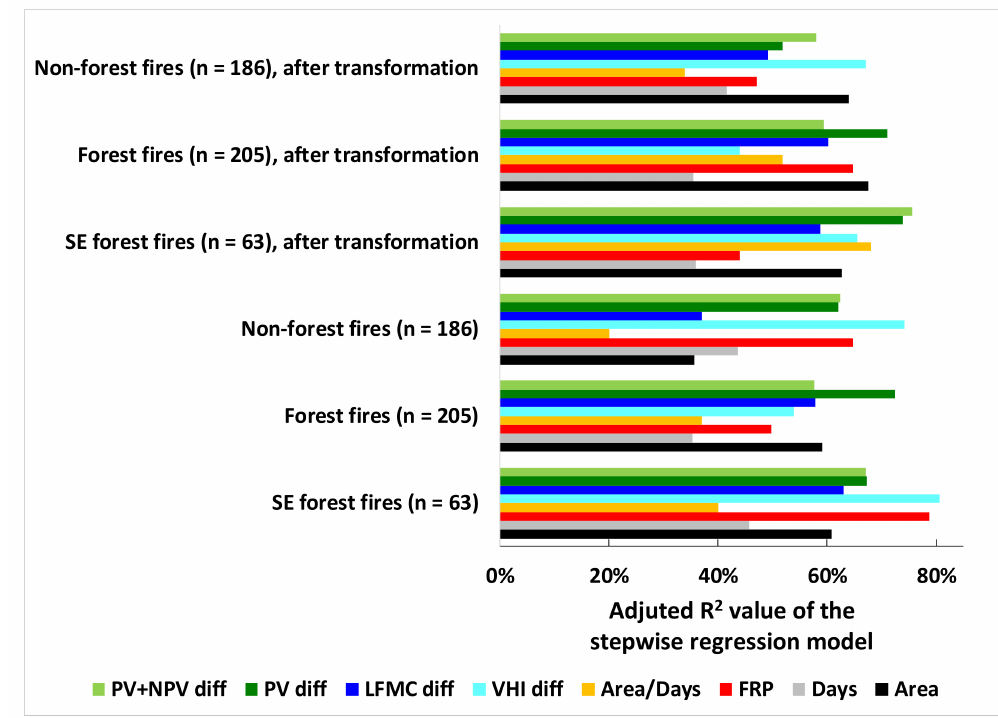
Figure 12. Adjusted R 2 values of the stepwise regression models for the Black Summer fires. Models were run for all response variables, the non-forest fires ( n = 186), the forest fires ( n = 205) and the forest fires in SE Australia ( n = 63).